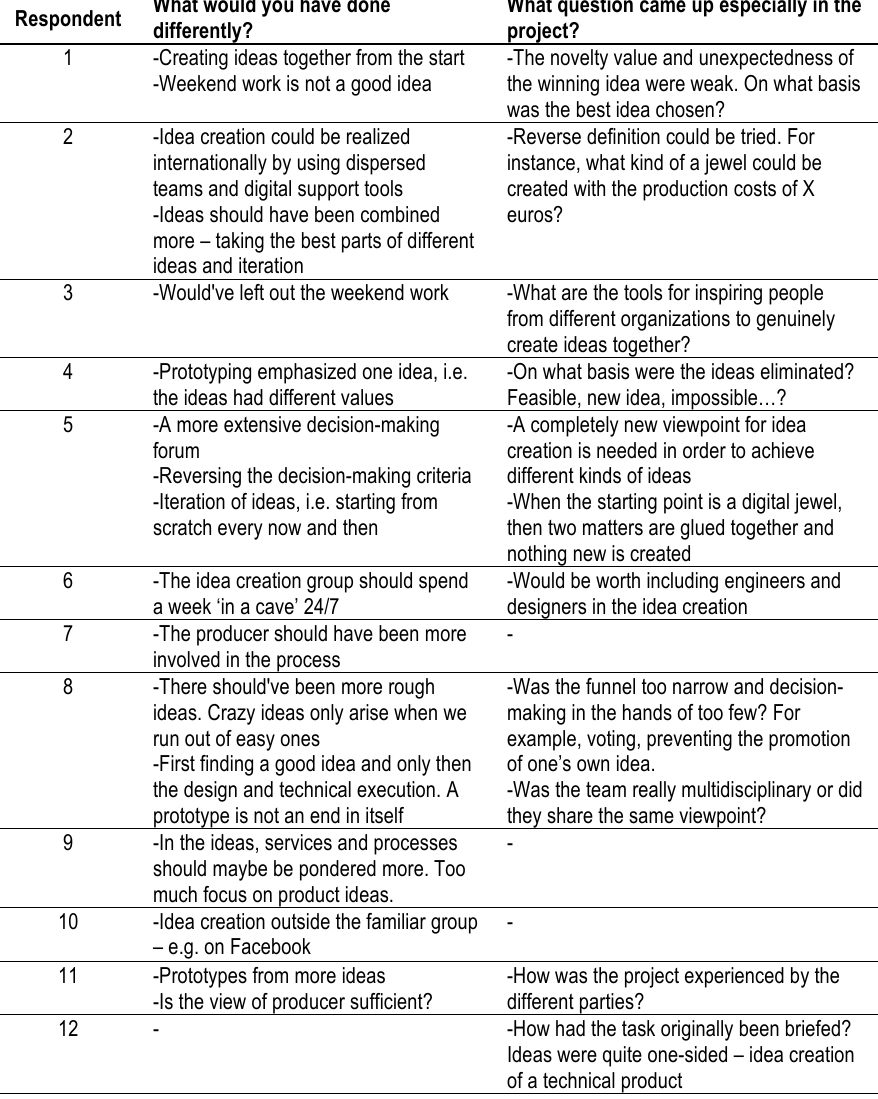
Table 5. Views of the evaluation group regarding the idea creation